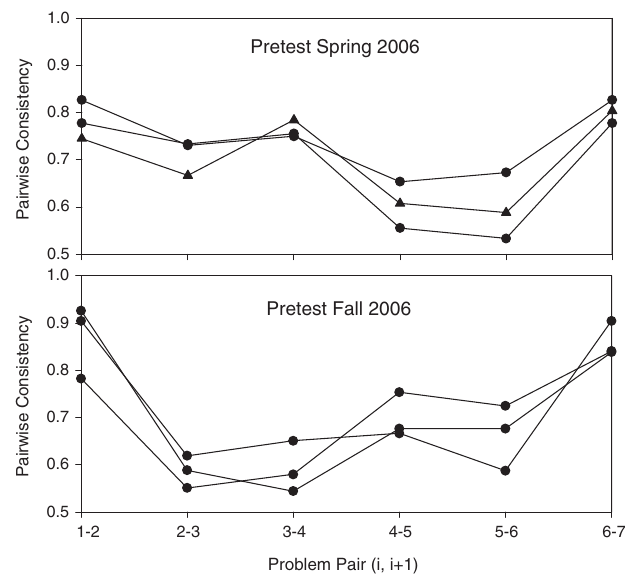
FIG. 1. Consistency of student response to pretest questions. i is plotted against the The average pairwise consistency h C i;i þ 1 location of the pair of problems in the test. The three lines represent the three orders of the problems.